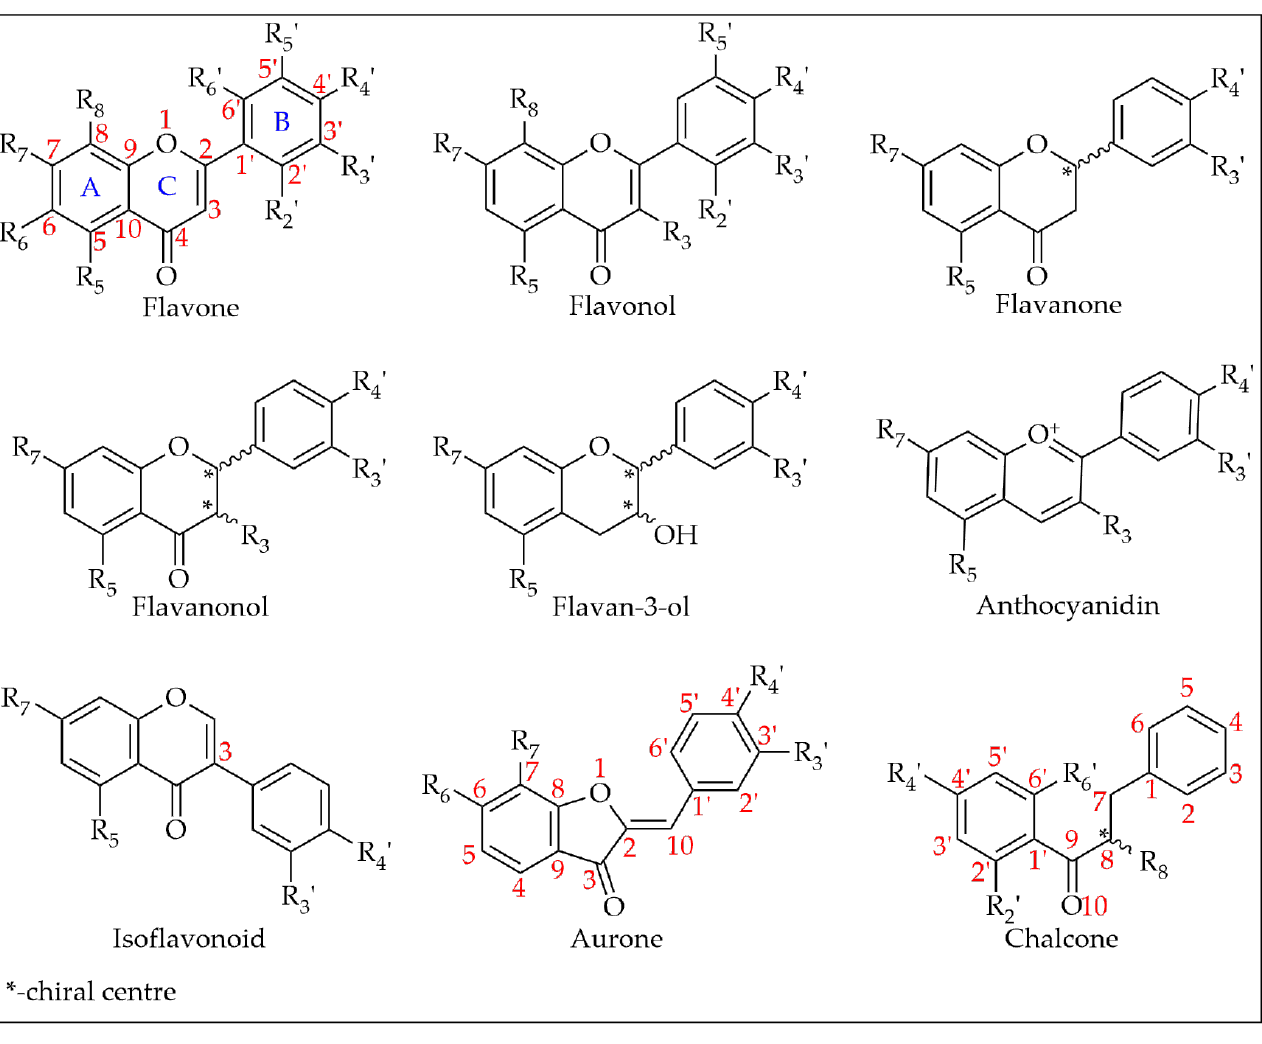
Figure 6. Flavonoid subclasses reported in monofloral honeys.